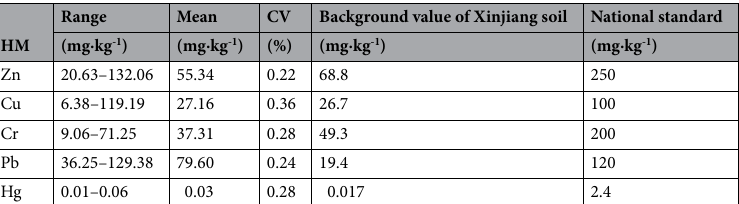
Table 3. Descriptive statistical results for the heavy metals in the soil. Background values are based on the background values for soil elements in Xinjiang (Zhang et al. 49 ). National standard values are based on soil environmental quality standards (GB